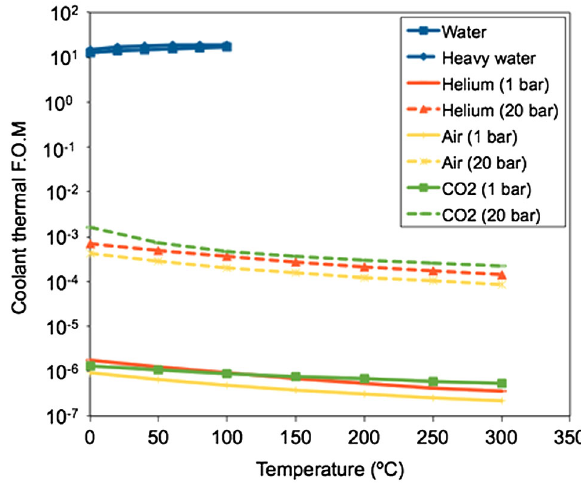
FIG. 2 (color online). Thermohydraulic figure of merit for different target coolants at different operating temperatures and pressures.